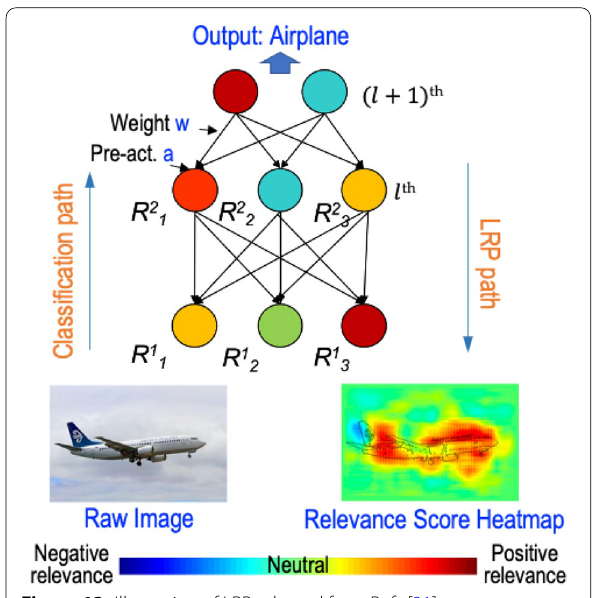
Figure 13 Illustration of LRP, adapted from Ref.